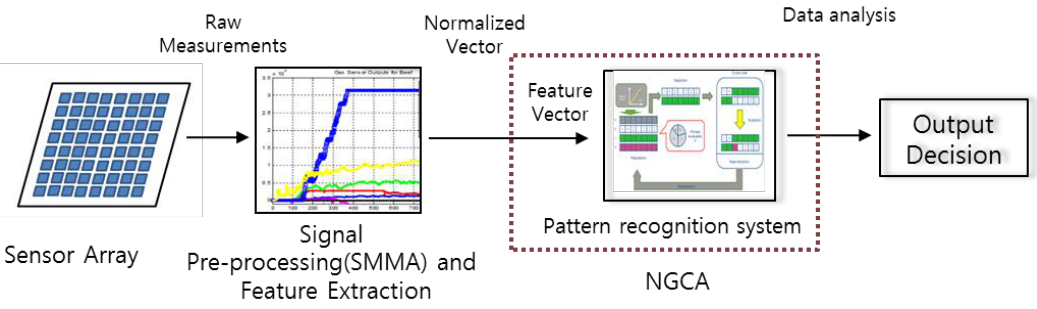
Figure 1. Pattern recognition system